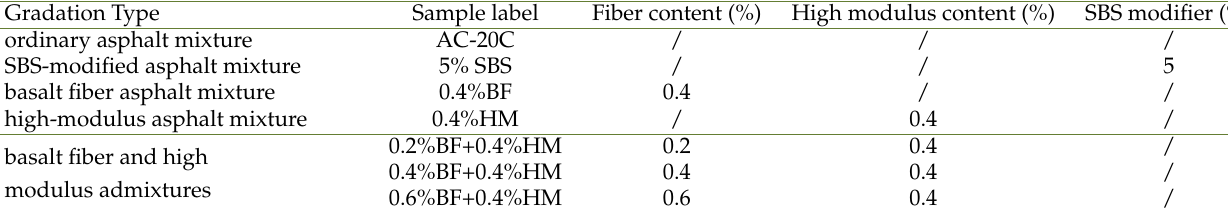
Table 3. Test samples and their